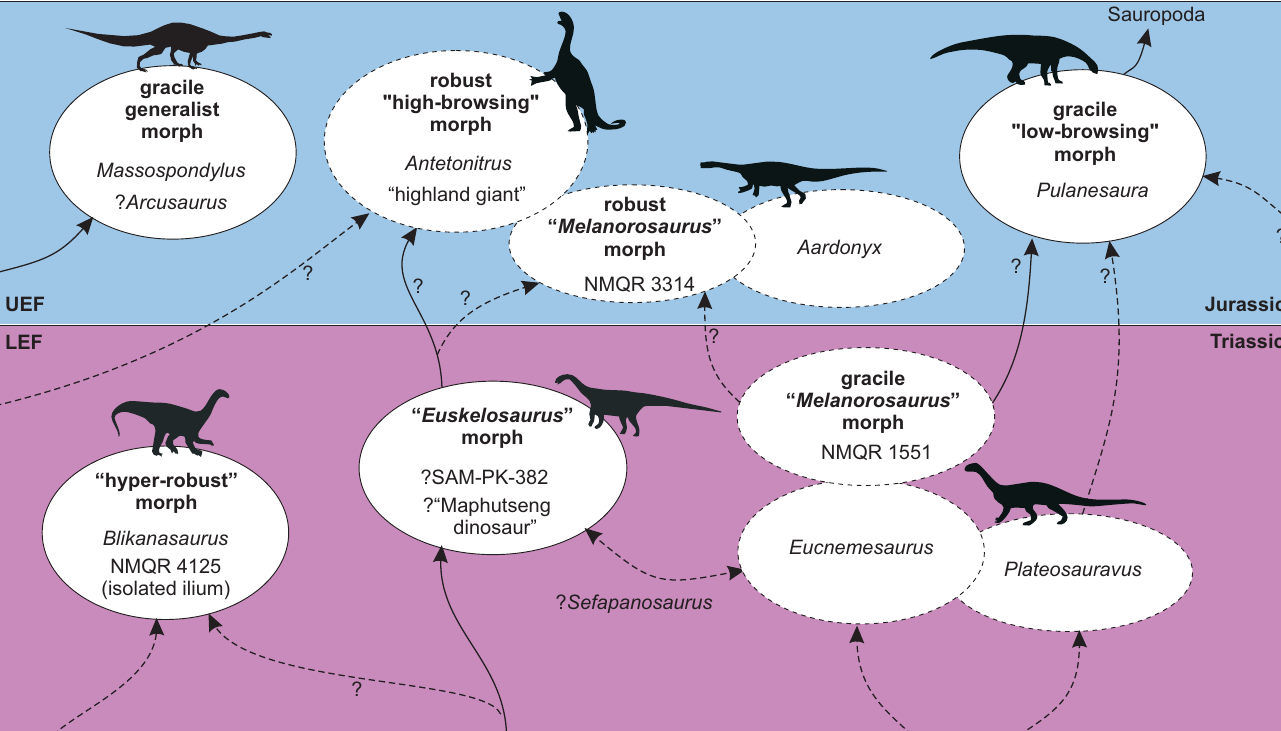
Fig. 9. Schematic representation of hypothetical ecomorphotype groupings and population dynamics of the sauropodomorph fauna of the Elliot